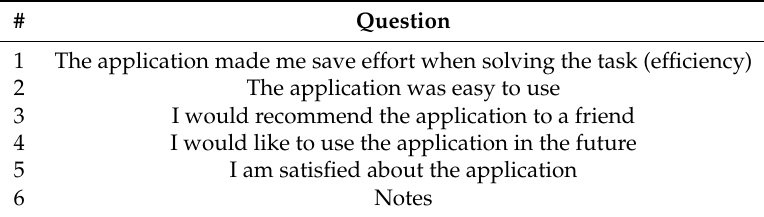
Table 4. Post-test questionnaire translated from the Italian